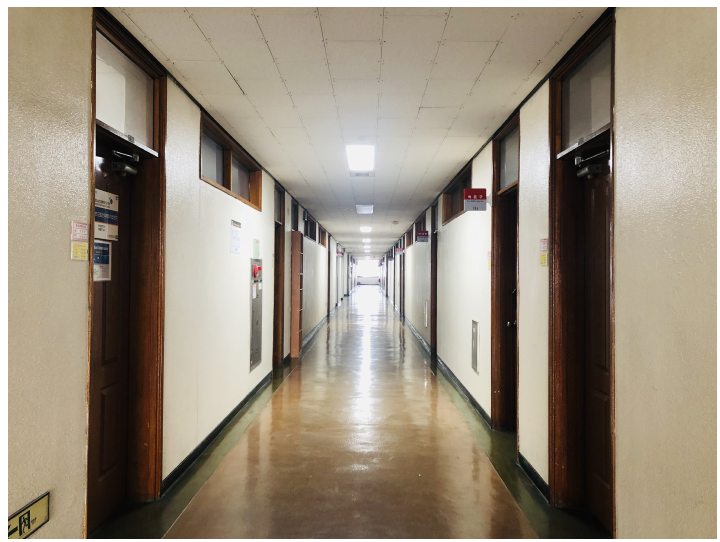
Figure 18. Real corridor environment on the 3rd floor of Kyungpook National University (KNU) IT-1